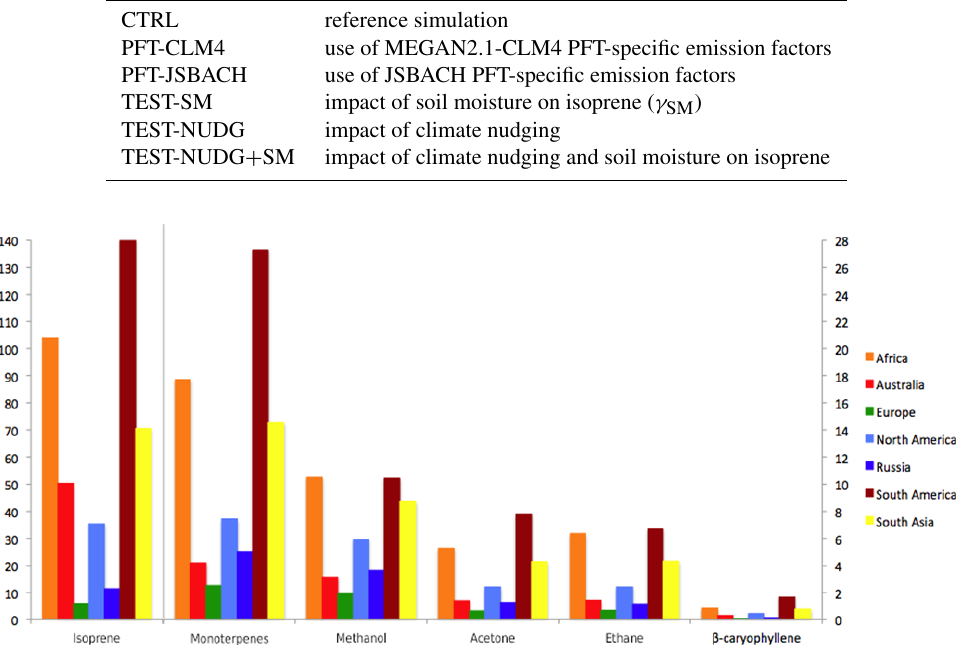
Figure 1. Regional annual emissions (TgCyr − 1 ) for isoprene, the sum of monoterpenes, methanol, acetone, ethene, and β -caryophyllene averaged over the 12 years (2000–2012) of the reference simulation. y axes scales are separated for isoprene and the other compounds. The geographical regions considered here are Africa ( − 35 to 37 ◦ N and − 20 to 65 ◦ E), Australia ( − 50 to − 10 ◦ N and 110 to 179 ◦ E), Europe (36 to 75 ◦ N and − 15 to 50 ◦ E), North America (13 to 75 ◦ N and − 170 to − 40 ◦ E), Russia (37 to 75 ◦ N and 50 to 179 ◦ E), South America ( − 60 to 5 ◦ N and − 90 to − 36 ◦ E), and South Asia ( − 10 to 37 ◦ N and 110 to 179 ◦